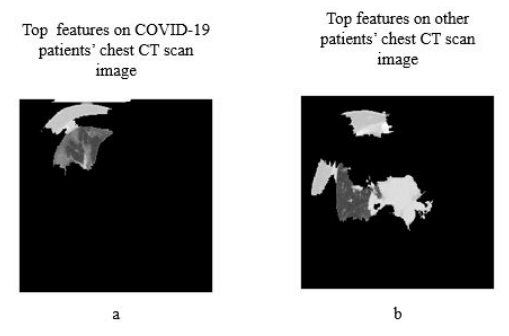
Figure 10. Top four features ( a ) on COVID-19 patients CT scan image ( b ) on other patients CT scan image.